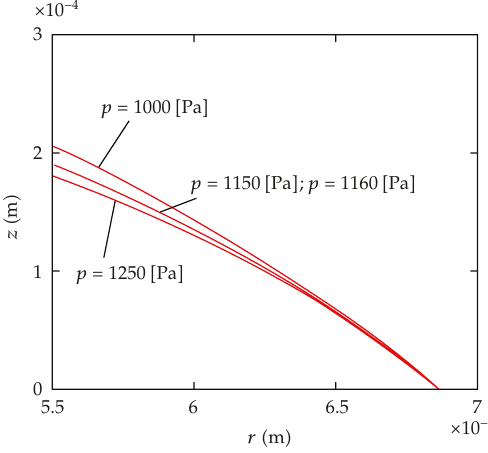
Figure 4: z versus r for p (cid:2) 1000 , 11500 , 1160 , 1250 (cid:5) Pa (cid:7)